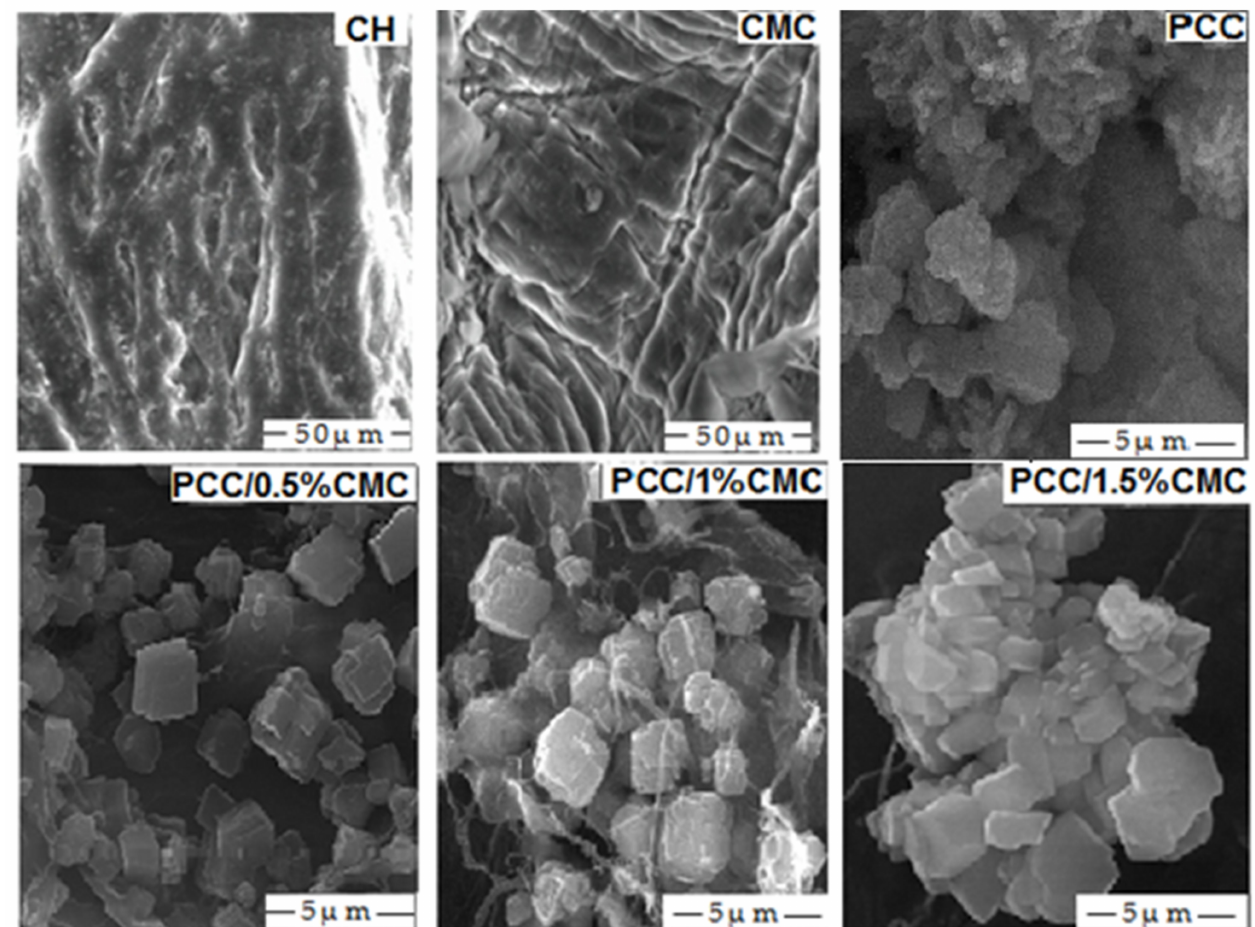
Figure 3. SEM images of CH, CMC, PCC, and PCC with addition CMC. The three polymorphic forms of precipitated calcium carbonate are calcite (thermo- dynamically stable at room temperature), vaterite, and aragonite, which are easier to be transformed into